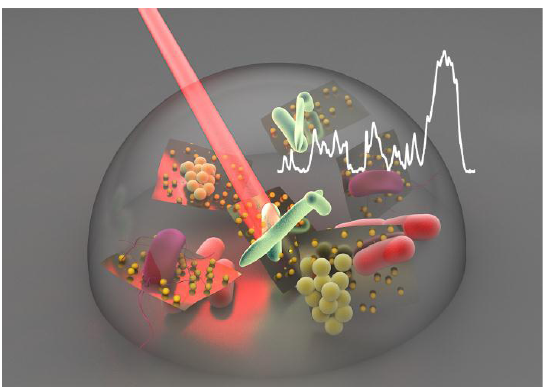
Fig. 1. Schematic illustration of the SERS sensing of food- borne pathogenic bacteria based on HfTe 2 -Au